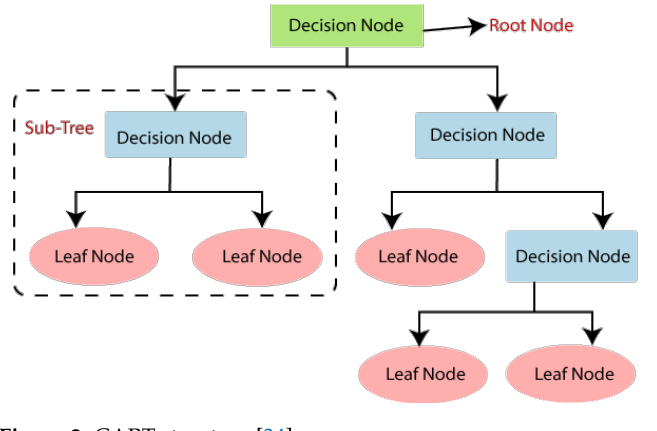
Figure 2. CART structure [34].